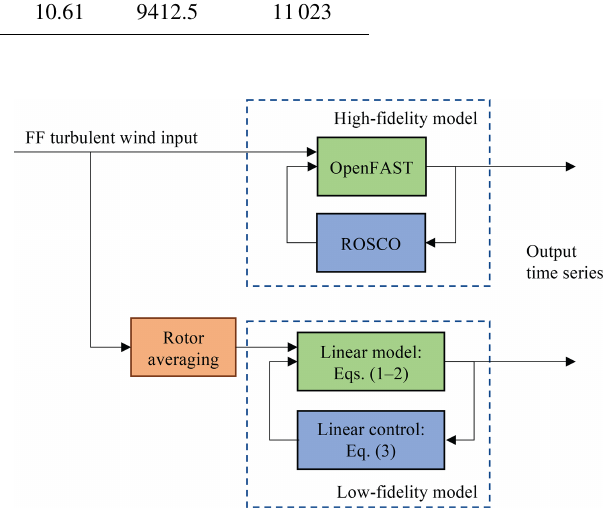
Figure 6. High- and low-fidelity control models. The high-fidelity model runs OpenFAST with the ROSCO controller and a full- field (FF) turbulent wind input. The low-fidelity models are de- scribed in Eqs. (1)–(3) and use a rotor-averaged wind speed as the input. Both models output time series that can be processed to de- rive operational and load